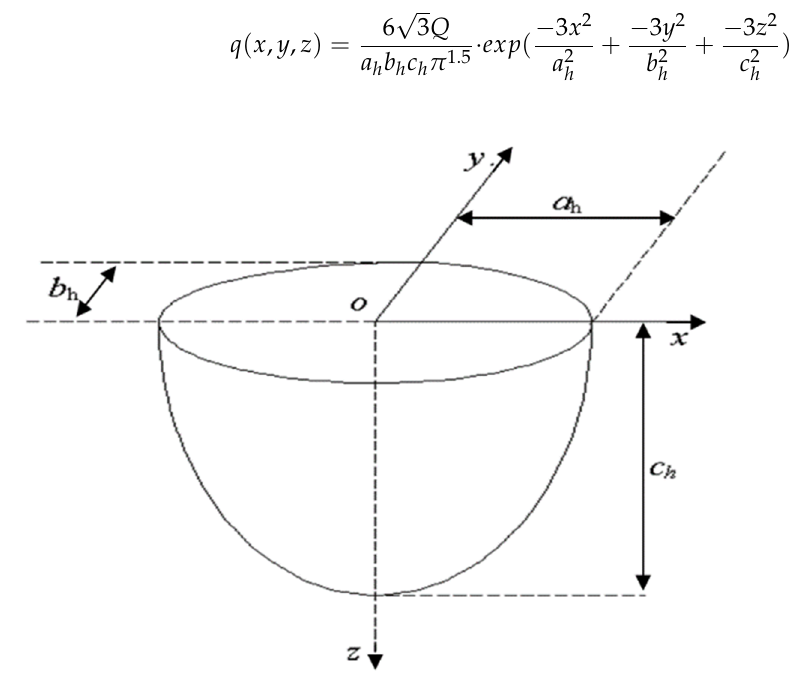
Figure 4. Schematic diagram of semi-ellipsoid domain.